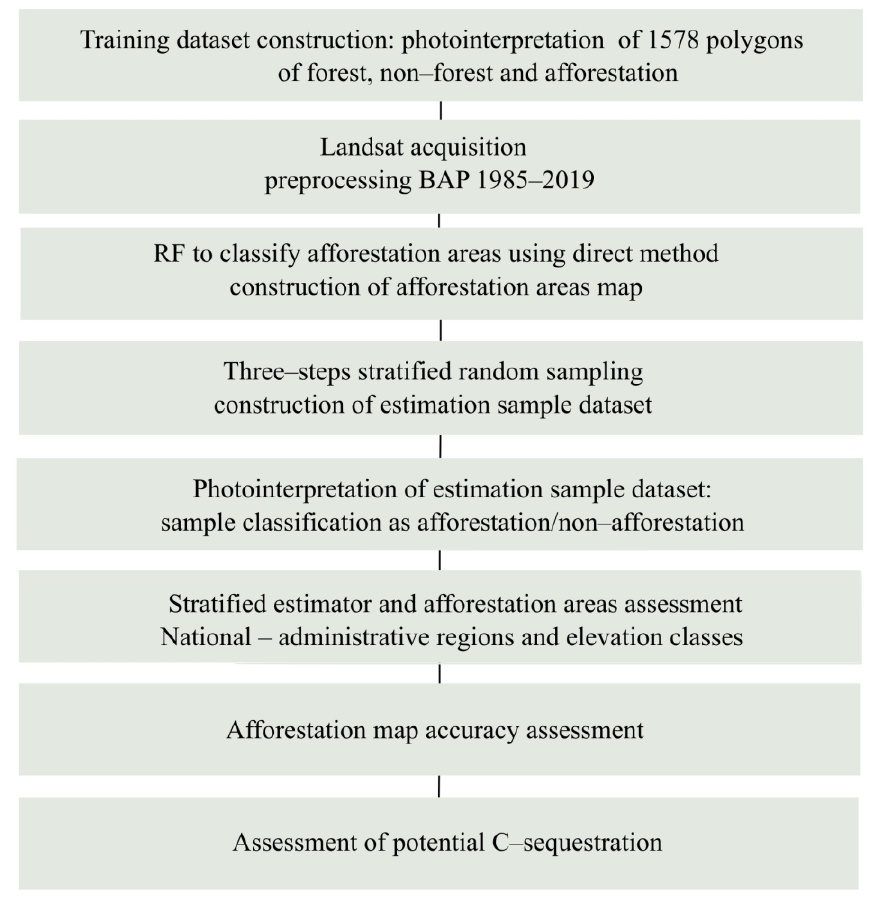
Figure 2. Flowchart of the methods.